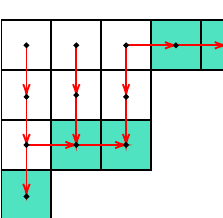
Figure 2. A tree permitted by the boundary condition corresponding to non-zero expectation values at the boundary. The boxes in λ B are